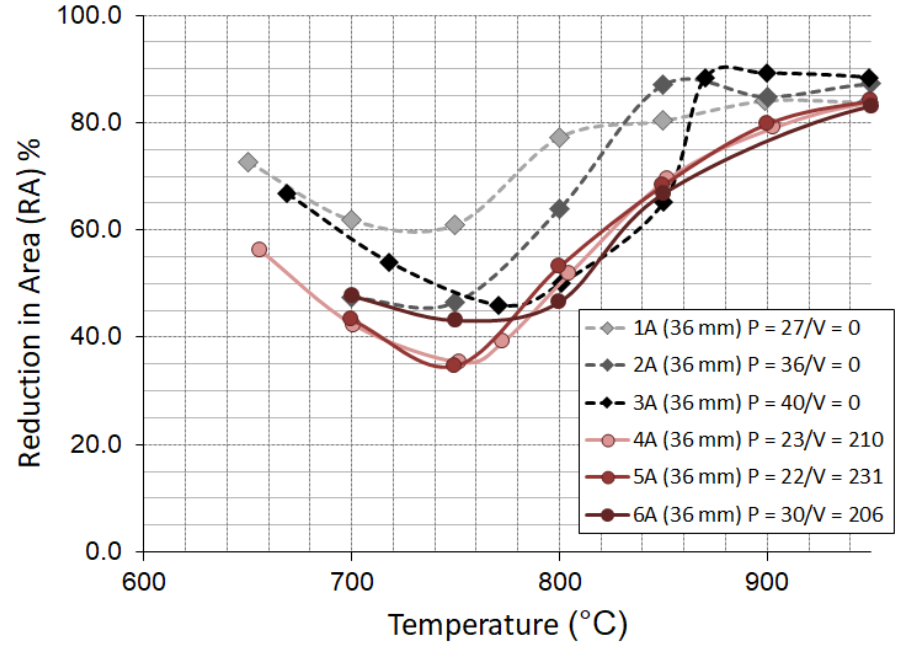
Figure 7. Hot ductility curves for the V-free steels (dashed lines) and V steels (solid lines) examined in the solution-treated condition.